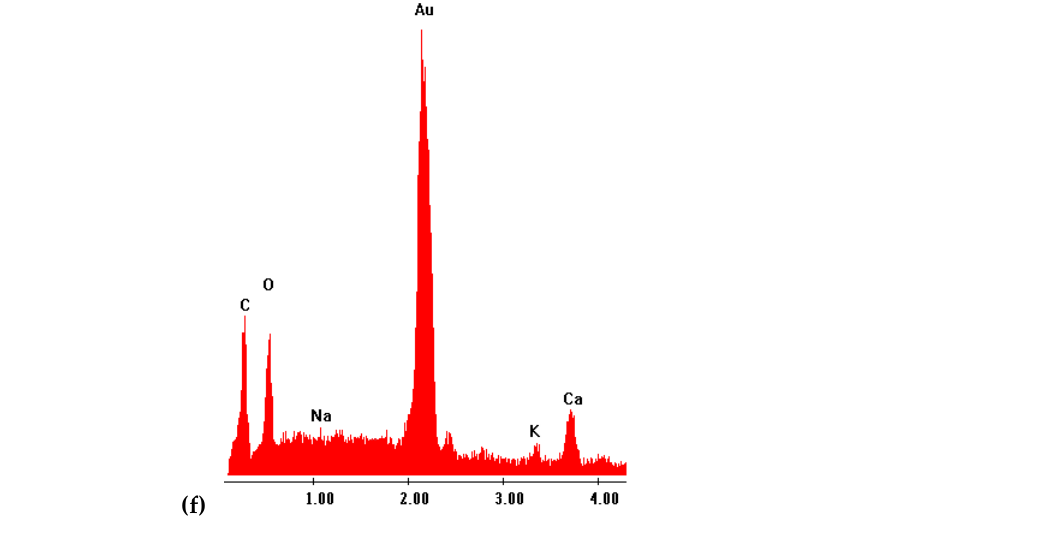
Figure 2. ( a ) SEM 500 × surface image of CHT film; ( b ) SEM 500 × transversal image of CHT film; ( c ) EDX analysis of CHT film; ( d ) SEM 500 × surface image of CHA film; ( e ) SEM 500 × transversal image of CHA film; ( f ) EDX analysis of CHA film.